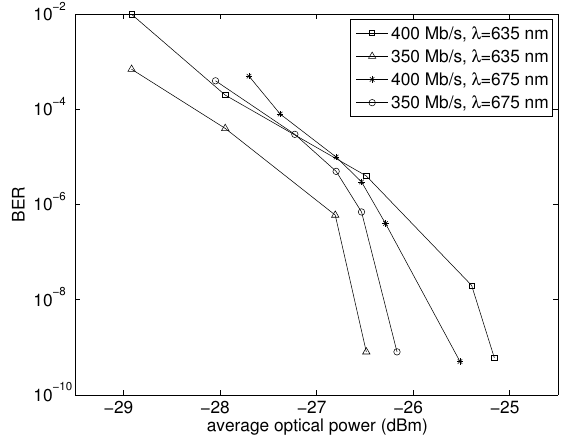
Figure 4. Sensitivity (corrected for ER = ∞ ) at 350Mbit/s and 400Mbit/s for λ = 635nm, extinction ratio = 10and λ = 675nm, extinction ratio = 5.5. 2 31 − 1